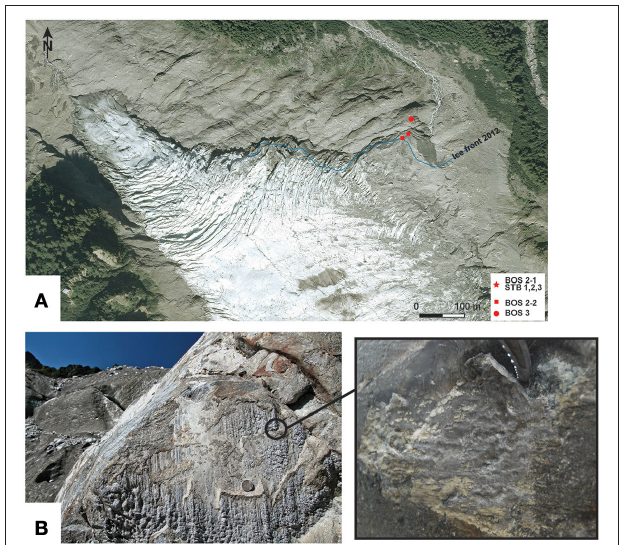
FIGURE 2 | (A) Location of the cryocarbonate samples reported on the 2008 aerial photograph from the IGN ORTHO ® 2.5m database. Samples BOS 2-1, STB 1-3, and BOS 2-2 were located under the glacier and sample BOS 3 was in proglacial position in 2008. The blue line marks the 2012 glacier front position. (B) Cryocarbonate samples outcropping on the lee side of the vertical roches-moutonées show a fluted surface parallel to the direction of the ice flow. Right panel zooms into an area to show